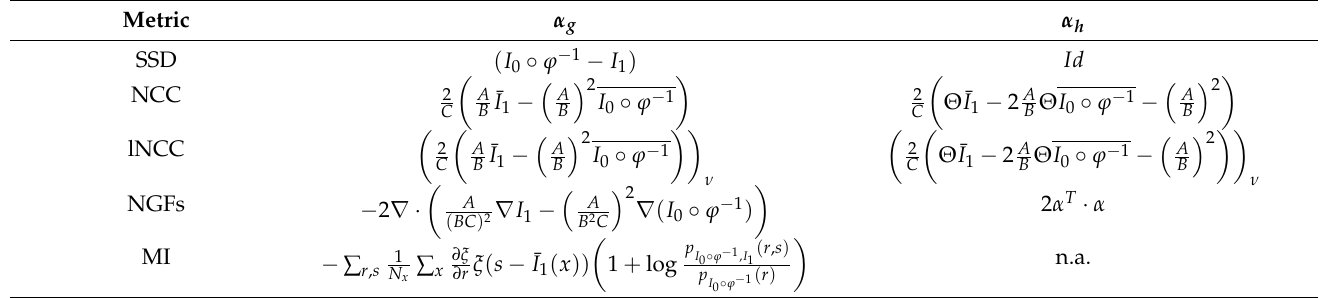
) ν in lNCC indicates the ϕ − 1 . The notation ( ◦ ·